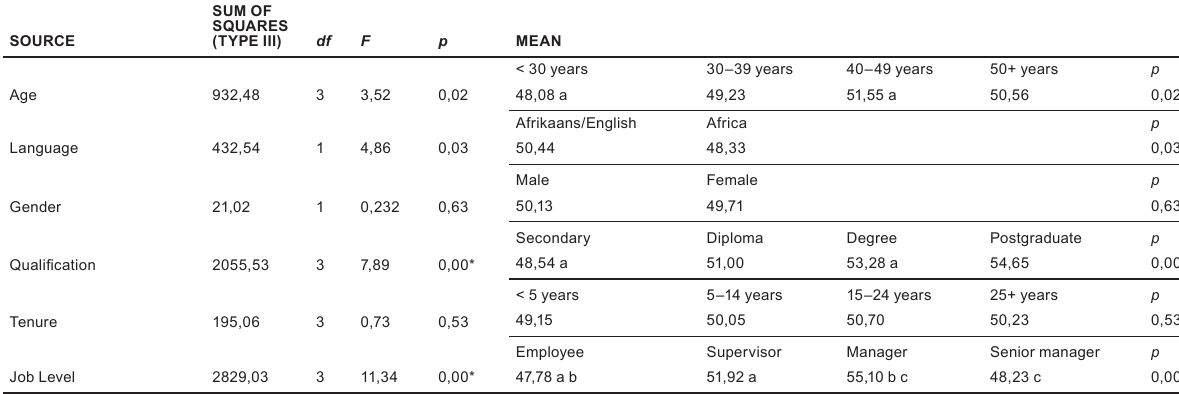
table 4 Analysis of variance – Orientation to Life Questionnaire (OLQ) (11